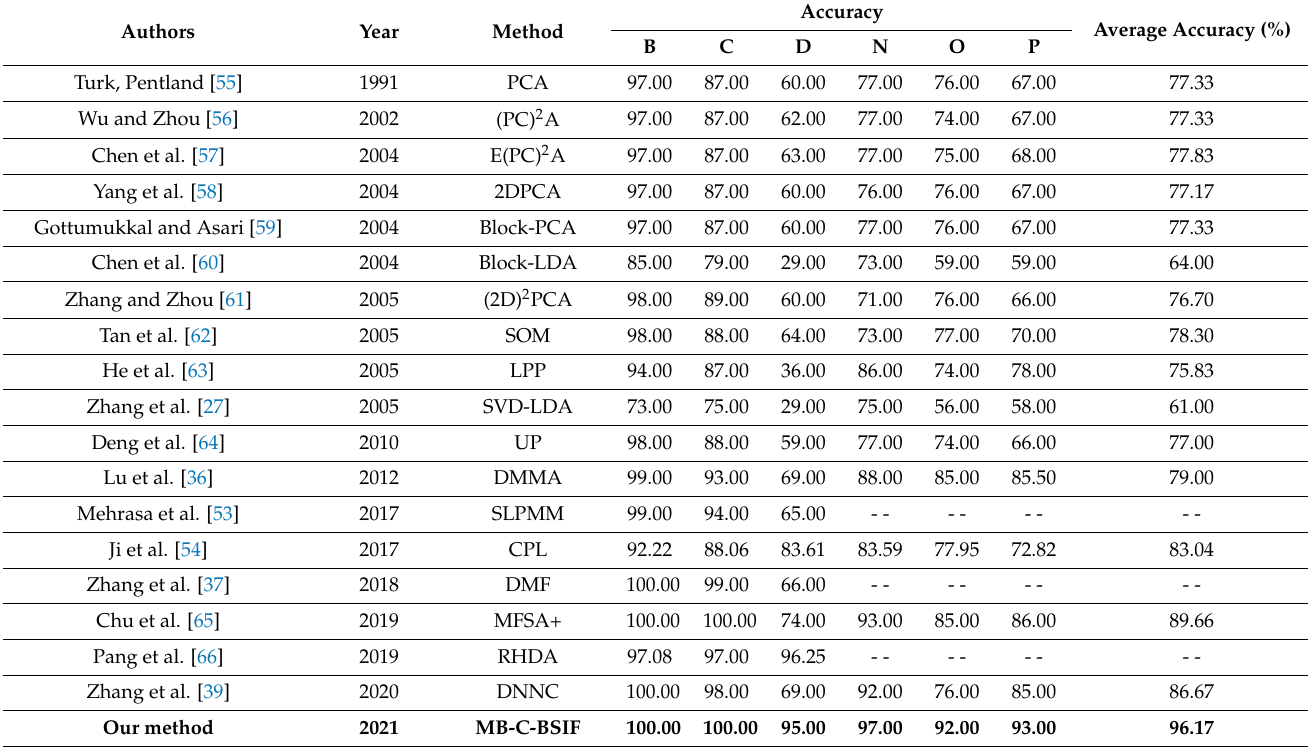
Table 13. Comparison of 18 methods of facial expression variation